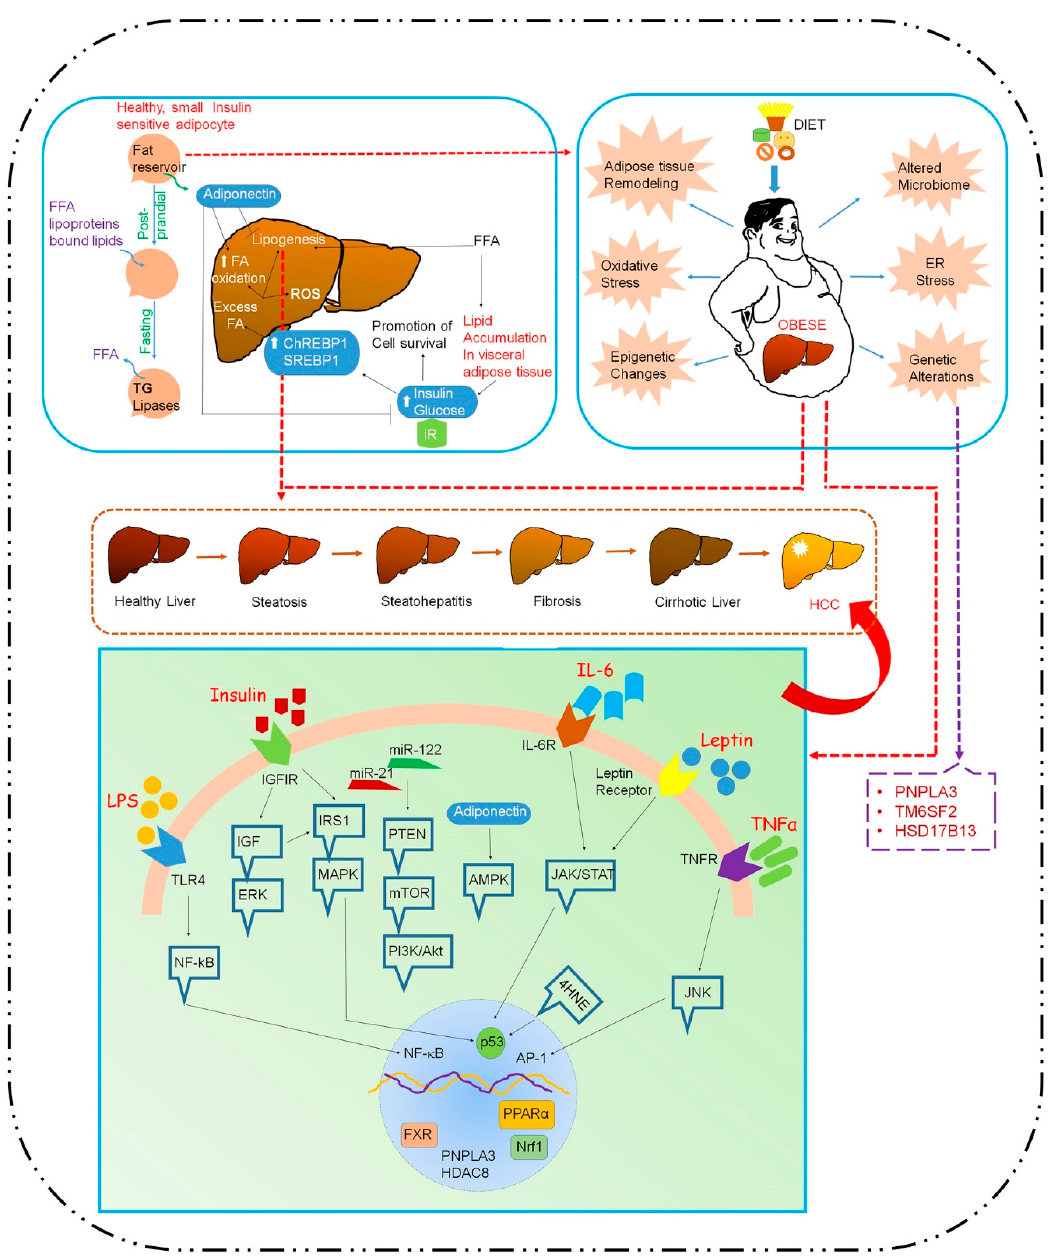
Figure 1. Molecular signaling pathways promoting HCC in the presence of obesity. Over-nutrition and a sedentary lifestyle induce adipose tissue remodeling, microbiome alteration, and ER and oxidative stress. These modifications, in association with genetic factors such as PNPLA3 and epigenetic changes, lead to the dysregulation of adipokine secretion and activation of the PI3K / Akt, JAK / STAT, NF- κ B, mTOR, 4-HNE, and NRF-1 oncogenic pathways. Healthy adipocytes, in response to the above stimuli, absorb lipids and secrete adiponectin, which promotes insulin sensitivity and FA oxidation and suppresses lipogenesis. In the fasting state, adipocytes release FAs whereas in obesity, they swell and dedifferentiate, releasing less adiponectin. Subsequent macrophage infiltration contributes to inflammation. Lipolysis releases free fatty acids (FFAs), leading to triglyceride accumulation in VAT that generates IR. High FFAs and IR lead to steatosis, followed by hepatic lipogenesis by the transcriptional regulators SREBP1 and ChREBP1. Steatosis is mostly benign, but in the presence of excess FAs that are not converted into triglyceride, there is an overload of mitochondrial FA oxidation with the generation of ROS that promotes liver tissue damage and inflammation (NASH). IR facilitates high circulating glucose